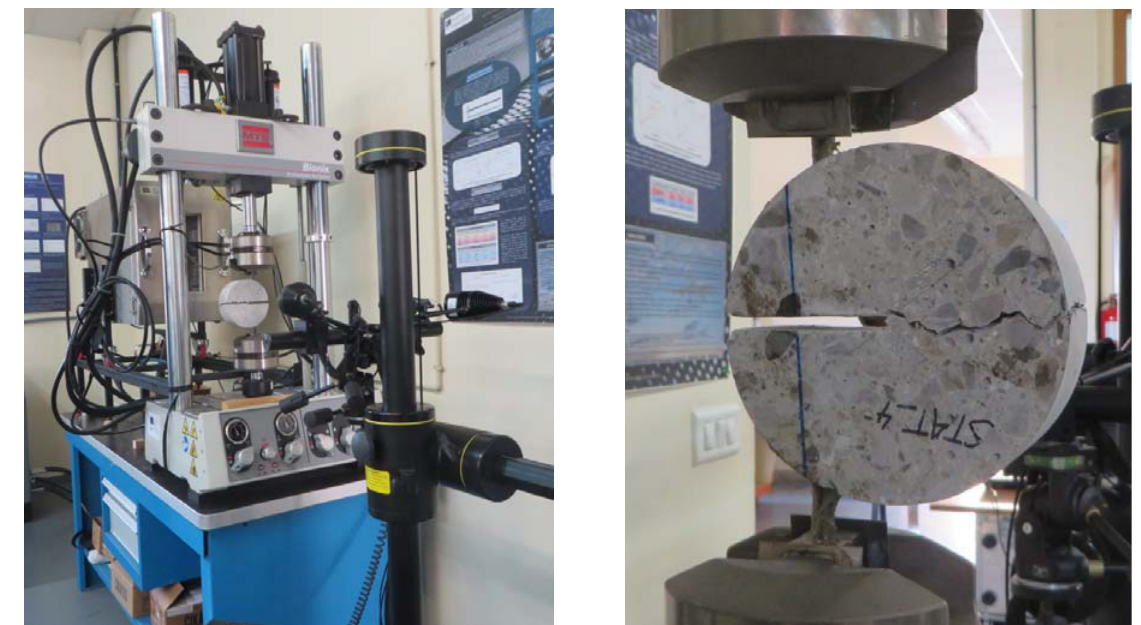
Figure 3: Specimen set up into the servohydraulic MTS Bionix 25 kN machine.